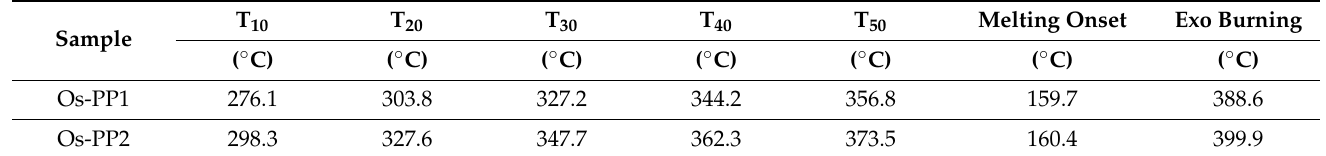
Figure 10. TG–DSC curves for osmium nanoparticles-polypropylene hollow fibers composite membranes: Os-PP1 ( a ); Os- PP2 ( b ); and their overlap ( c ). Table 2. Thermal characteristics of the obtained composite membranes. Table 2. Thermal characteristics of the obtained composite membranes.